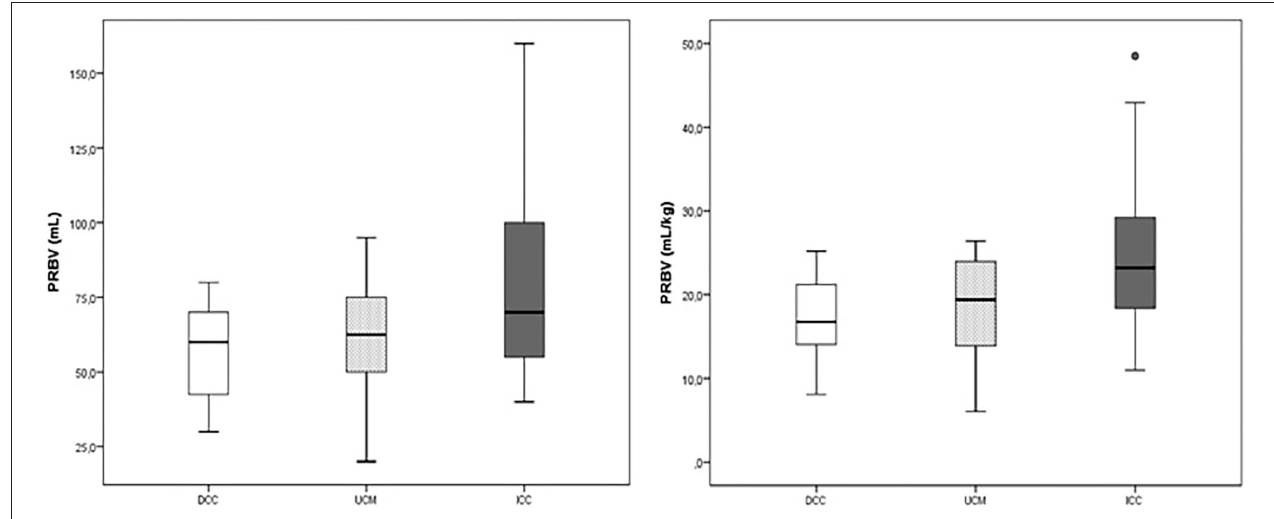
FIGURE 1 | The placental residual blood volume (PRBV) of the delayed cord clamping (DCC), umbilical cord milking (UCM), and immediate cord clamping (ICC) groups (ml and ml/kg).